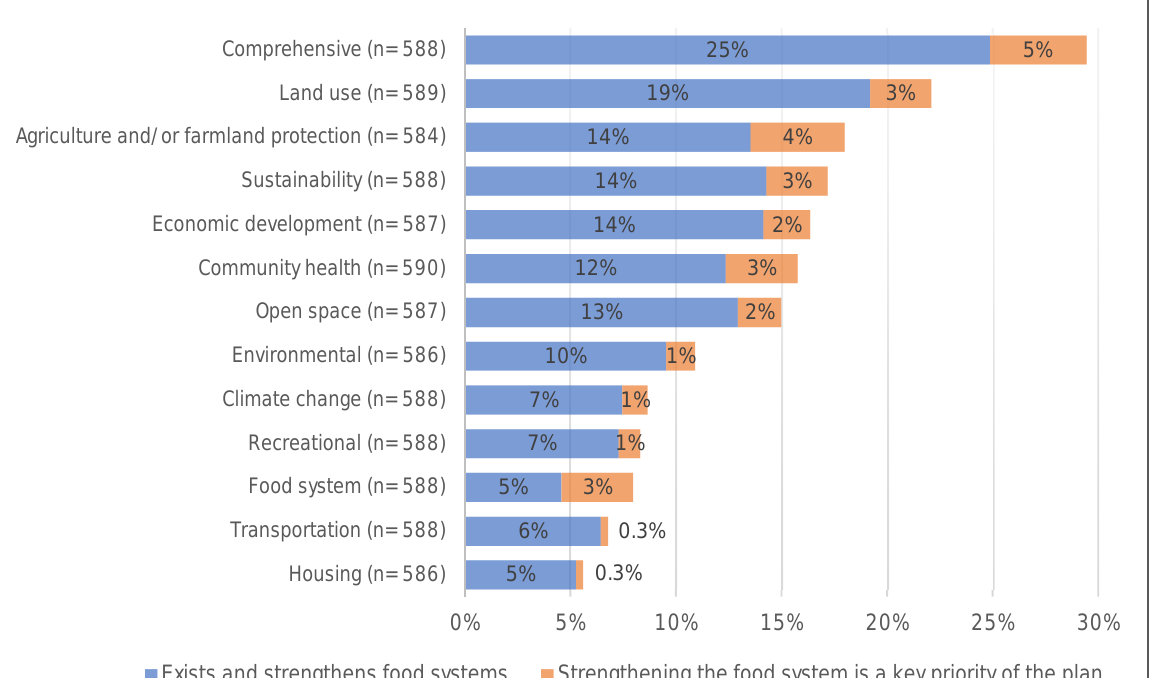
Figure 3. Comparison of Formal Plans Adopted by Local, Regional, and Metropolitan (LRM) Governments that Include the Food System as a Key Priority and to Strengthen the Food